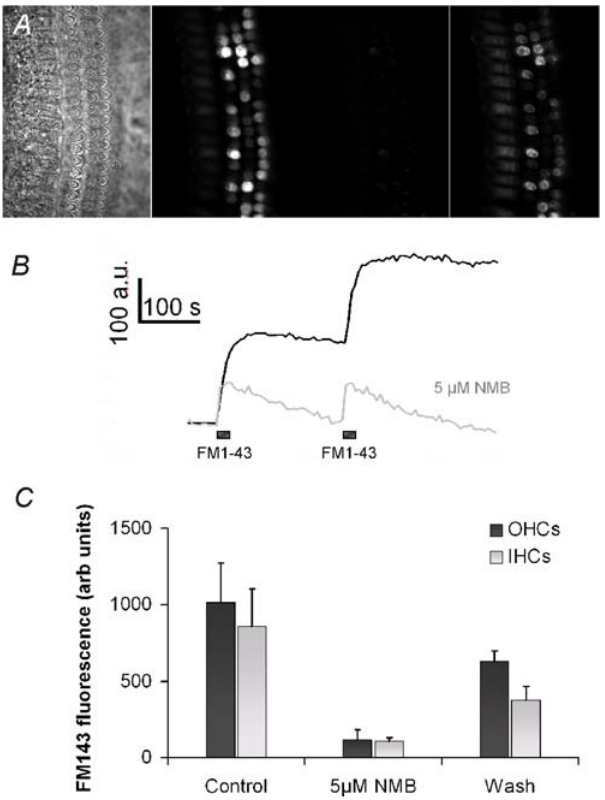
Figure 7. NMB-1 inhibits mechanotransduction in sensory hair cells from the rat cochlea. ( A ) Left panel shows DIC image of a rat cochlear culture. OHCs are clearly visible by their V-shaped sensory hair bundles. IHCs are out of focus in this view but their position is indicated for reference. FM1-43 was applied by local pipette perfusion for 10 seconds (two times). The confocal fluorescence images shown are subtracted images showing the change in FM1-43 derived fluorescence at the end of the 2 6 10 second applications. In the presence of 5 m M NMB-1 there is minimal FM1-43 loading. After washout FM1-43 loading recovers. ( B ) Time course data showing the loading of FM1-43 measure in a single outer haircellas a functionoftime during the two 10 secondapplications. Inthe presenceof5 m MNMB-1FM1-43loading isblocked.( C ) Pooled data showing the changes in FM1-43 fluorescence after 2 6 10 second applications from 4 different cultures (samples are averages from the same 3 cells in each experiment) for control, NMB-1 and subsequent recovery after wash out. Mechanotransduction-dependent loading of FM1-43 is blocked by 5 m M in both OHCs and IHCs.